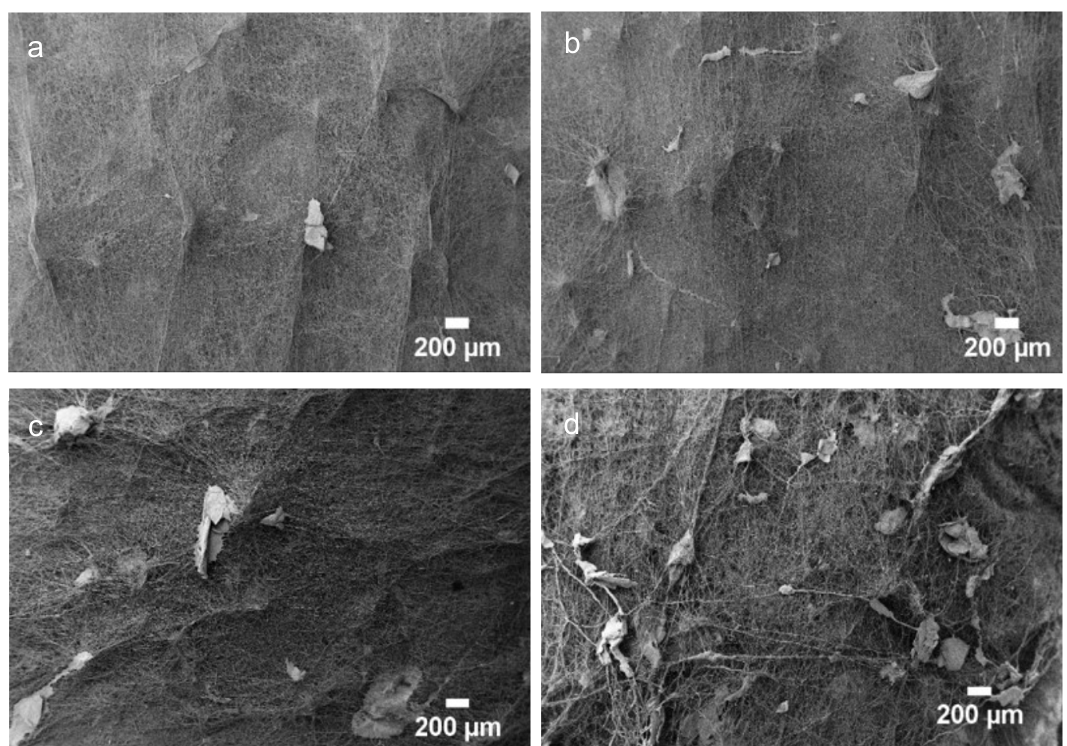
Figure 5. SEM images of electrospun PCL mats with CS flakes at different mass ratios: ( a ) 1:0.5, ( b ) 1:1, ( c ) 1:2 and ( d ) 1:3.